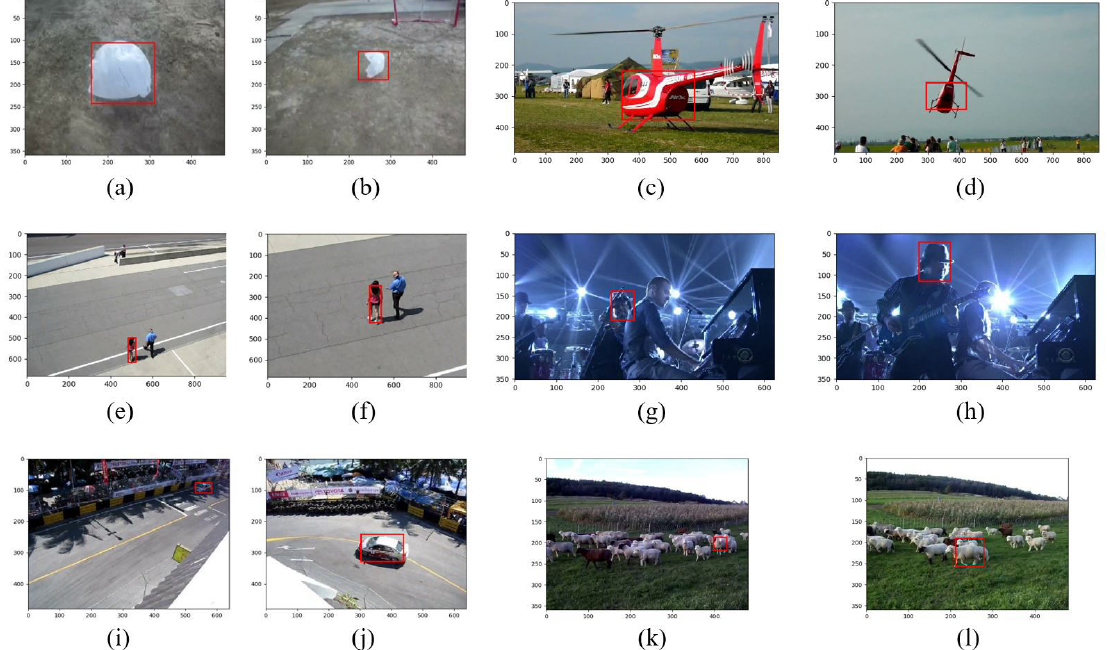
Figure 5. Screenshots of the tracking result from the proposed algorithm from VOT2018 dataset: bag ( a , b ), helicopter ( c , d ), crossing ( e , f ), shaking ( g , h ), racing ( i , j ), and sheep ( k , l